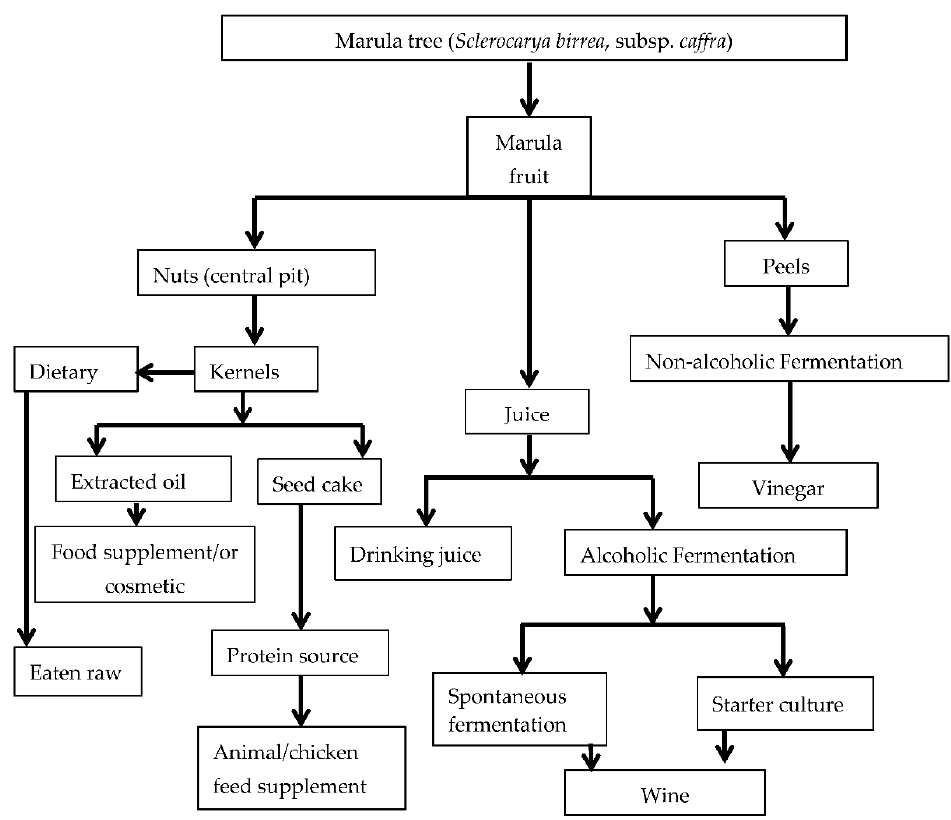
Figure 2. Bioprocessing of marula tree for the production of value-added products.